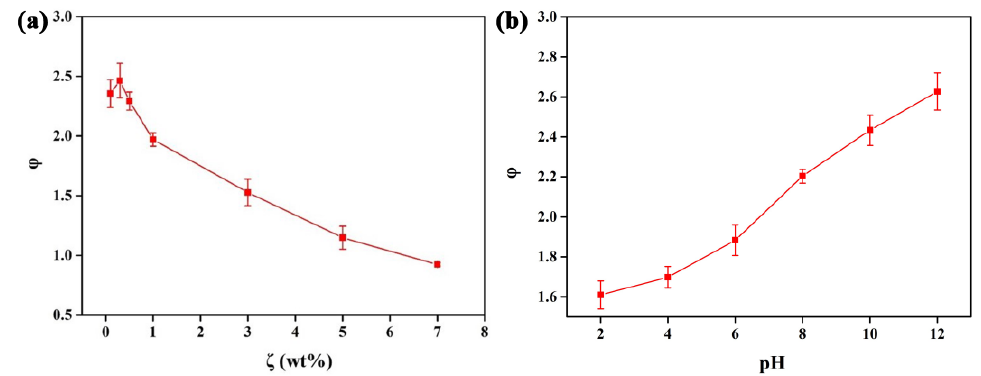
Figure 3. Swelling ratio ( ϕ ) of PAA gel film ( a ) at different amounts of TPGDA ( ζ ) and ( b ) at different pH. ϕ is defined as (m 2 − m 1 )/m 1 , where m 2 and m 1 are the mass of gel film in water and dry state, respectively.